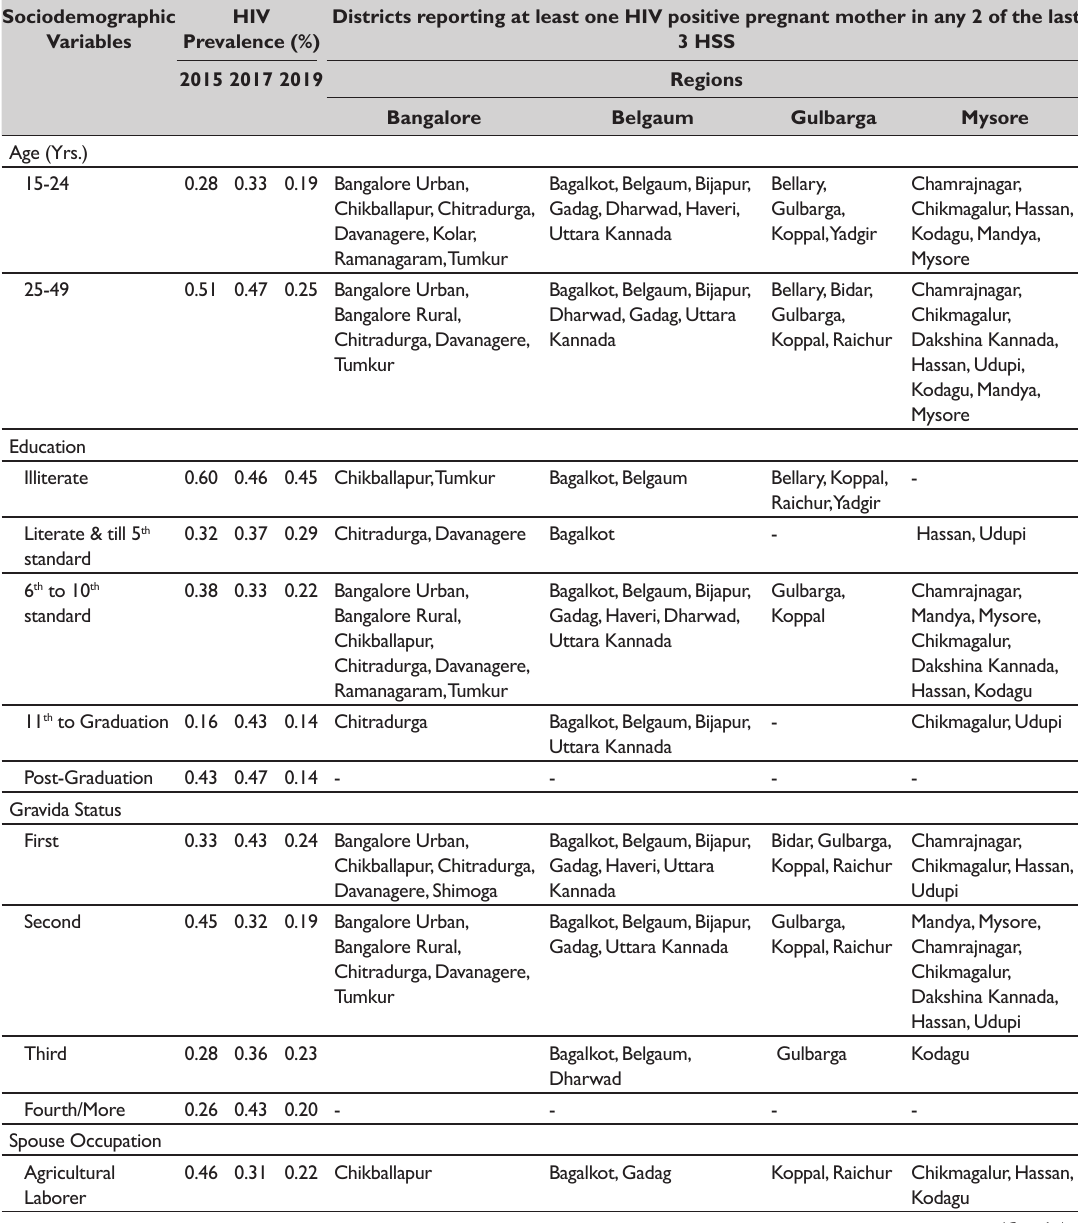
Table 3: HIV prevalence and districts reporting at least one HIV-positive pregnant woman in any 2 of the last three rounds of HIV Sentinel Surveillance based on the sociodemographic variables Sociodemographic